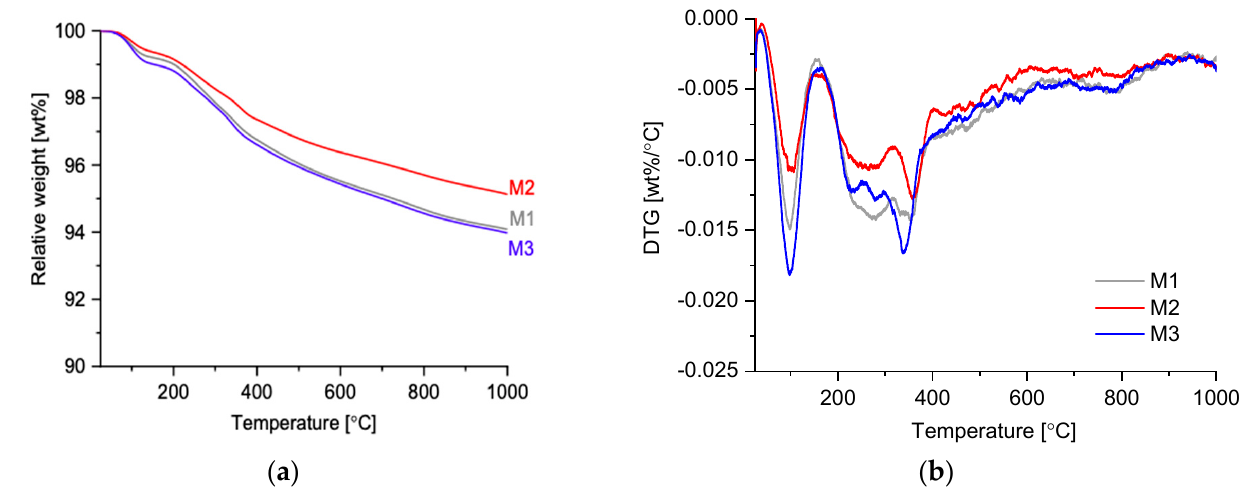
Figure 15. TG ( a ) and DTG ( b ) of residual materials after exposure to HCl.